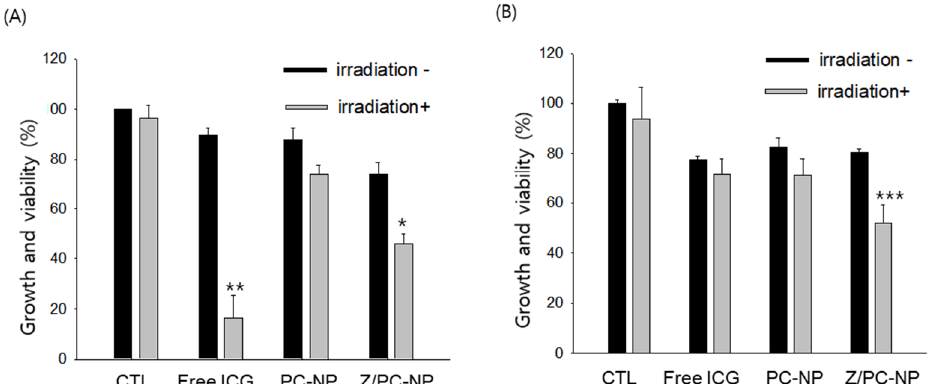
Figure 5. The effect of zein hybridization in PC - NP on the photocytotoxicity of encapsulated ICG. Each ICG formulation was used for treatment on the day of preparation ( A ) or after a four-day storage at room temperature ( B ). PC-NP and Z/PC-NP were prepared from 21.8 mg of lipid (DMPC:CHOL mixture) and 14.8 mg of lipid and 7 mg of zein mixture, respectively. Significant differences between treatments without irradiation or with irradiation are indicated by asterisks: * p < 0.05; ** p < 0.01; *** p < 0. 001.